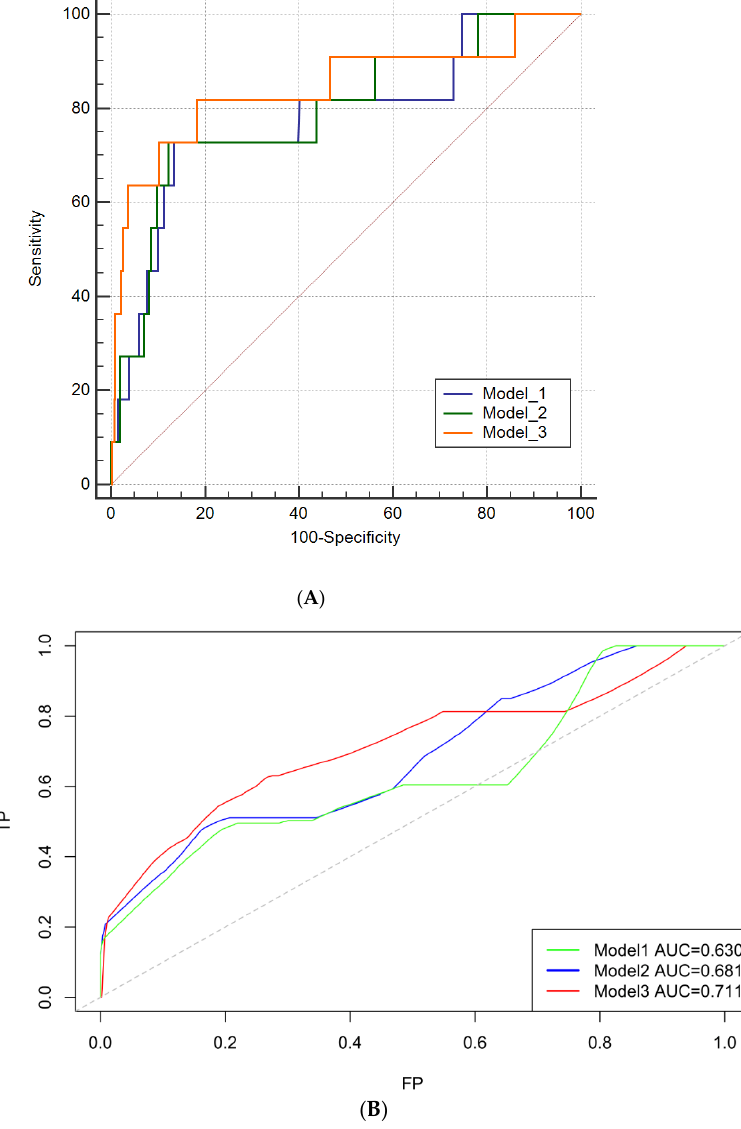
Figure 3. ROC curve ( A ) and time-dependent ROC curves ( B ) by different models for adverse clinical outcome. (Model 1, predictor of traditional risk factors including age, gender, hypertension, hyperlipidemia, diabetes, smoke, LDL, Hs-CRP, LVEF; Model 2, model 1 plus NT-proBNP; Model 3, model 2 plus plaque).